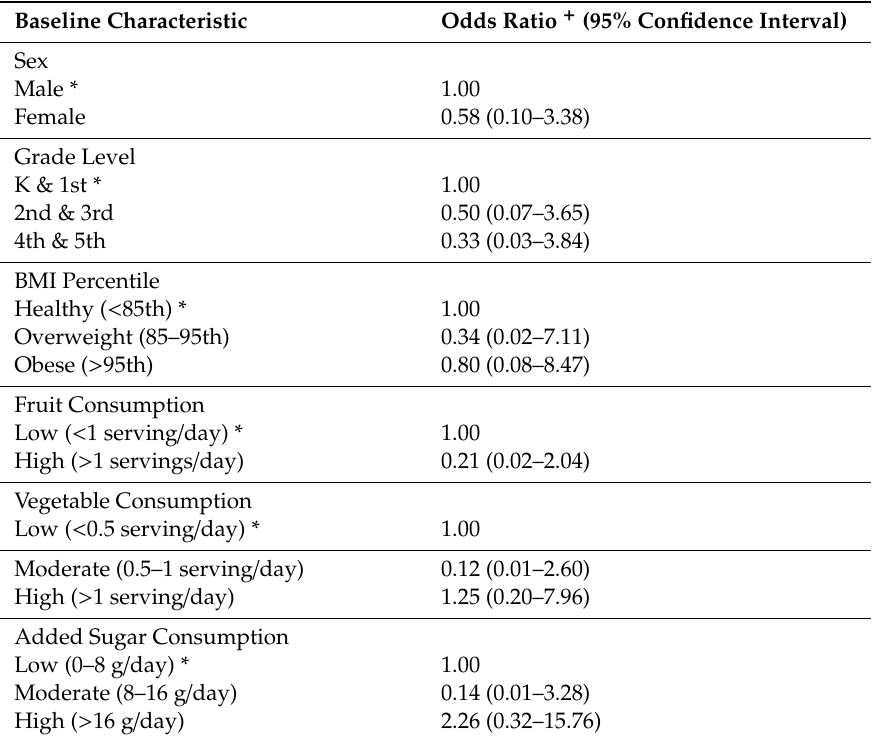
Table 3. Odds of selecting BPSL as opposed to TSL in meal condition 3 by baseline